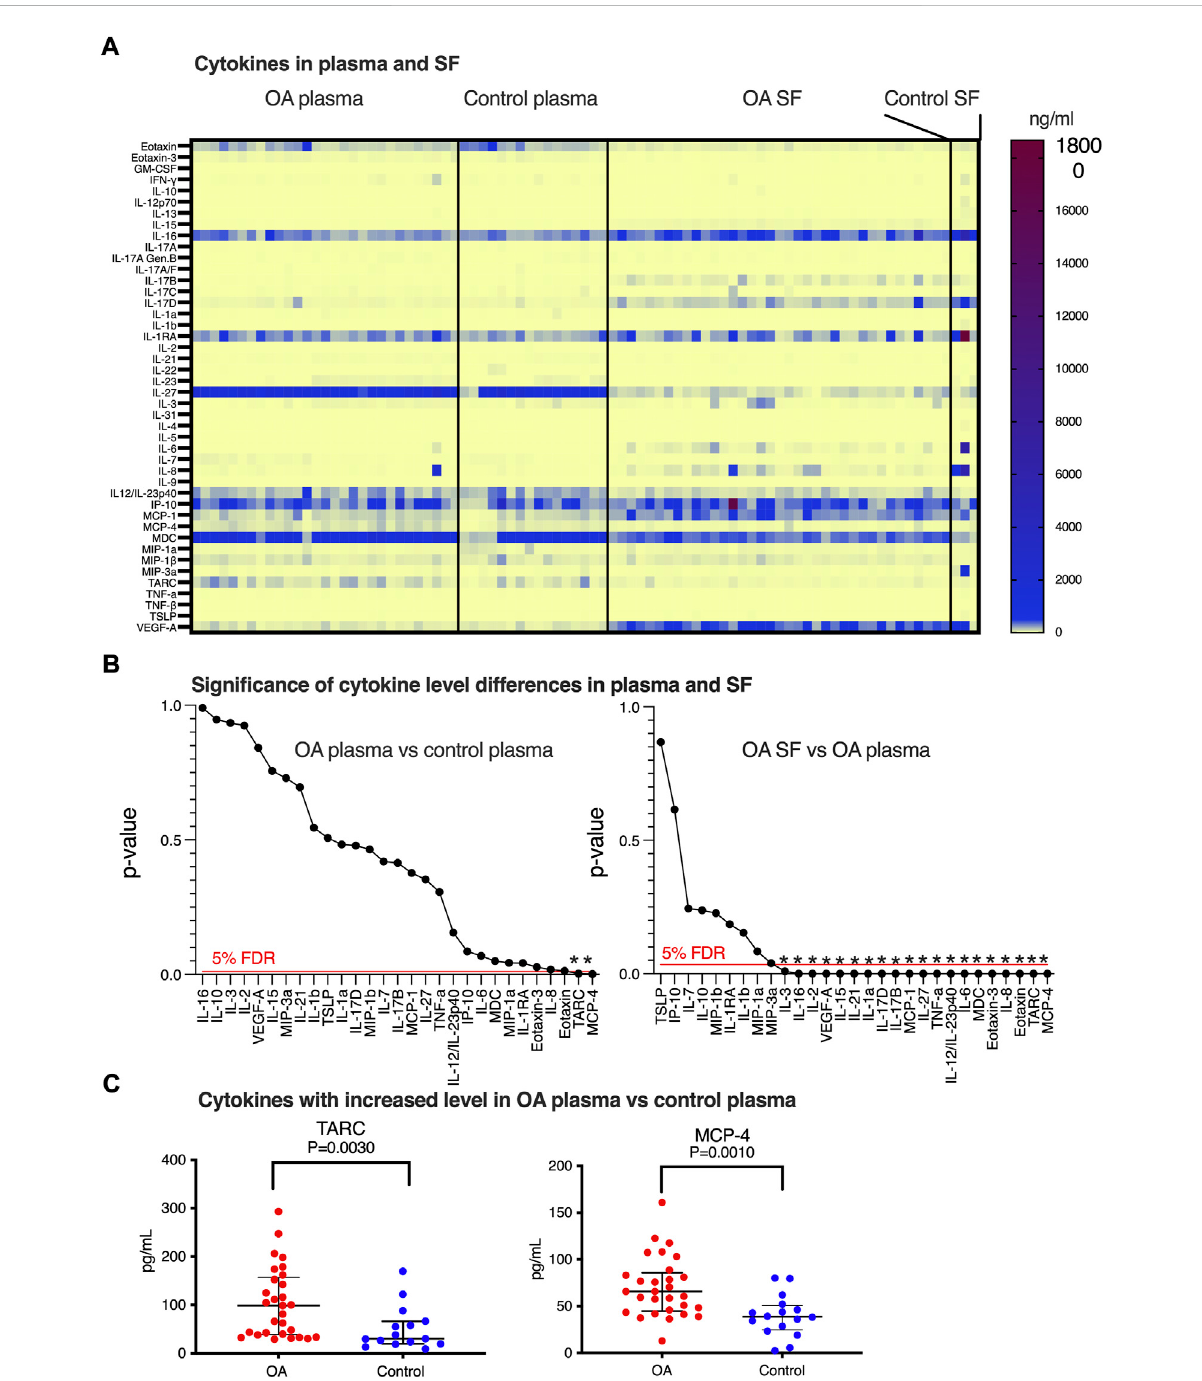
FIGURE 1 In fl ammatory marker expressions in SF and plasma. (A) Heatmap of biomarker levels in SF and plasma. Analysis was performed in 53 OA SFs, threecontrolSFs,29OAplasma,and16healthycontrolplasma.Eachrowstandsforonein fl ammatorymarkerandeachcolumnrepresentsasubject, and concentration levels (pg/ml) were indicated on the color scale. (B) Identi fi cation of biomarkers that differ between OA and control plasma (left) and OA SF and OA plasma (right) using multiple comparisons with 5% FDR and p -values calculated from comparing the biomarker levels individually. Statistically, signi fi cant differences are indicated by *. (C) Distribution of the levels of TARC and MCP-4 was found to be altered comparing OA plasma versus controls. Data were presented as median with interquartile, and a de fi nitive outlier was removed according to ROUT with Q =